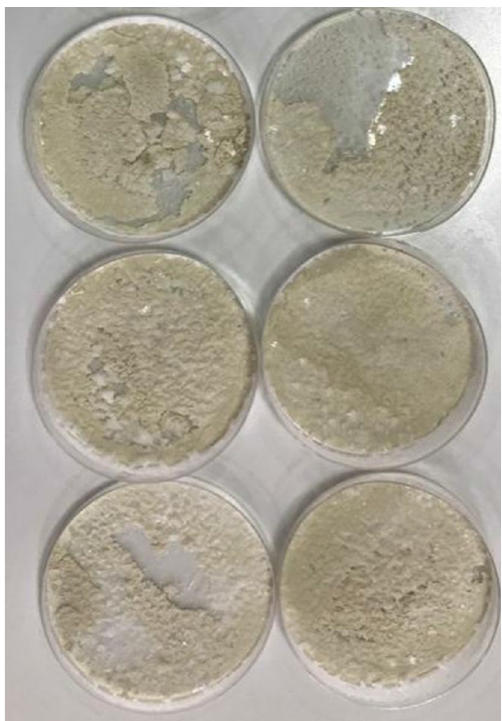
Figure 4. Demicrobized material for abiotic thiosulfate formation